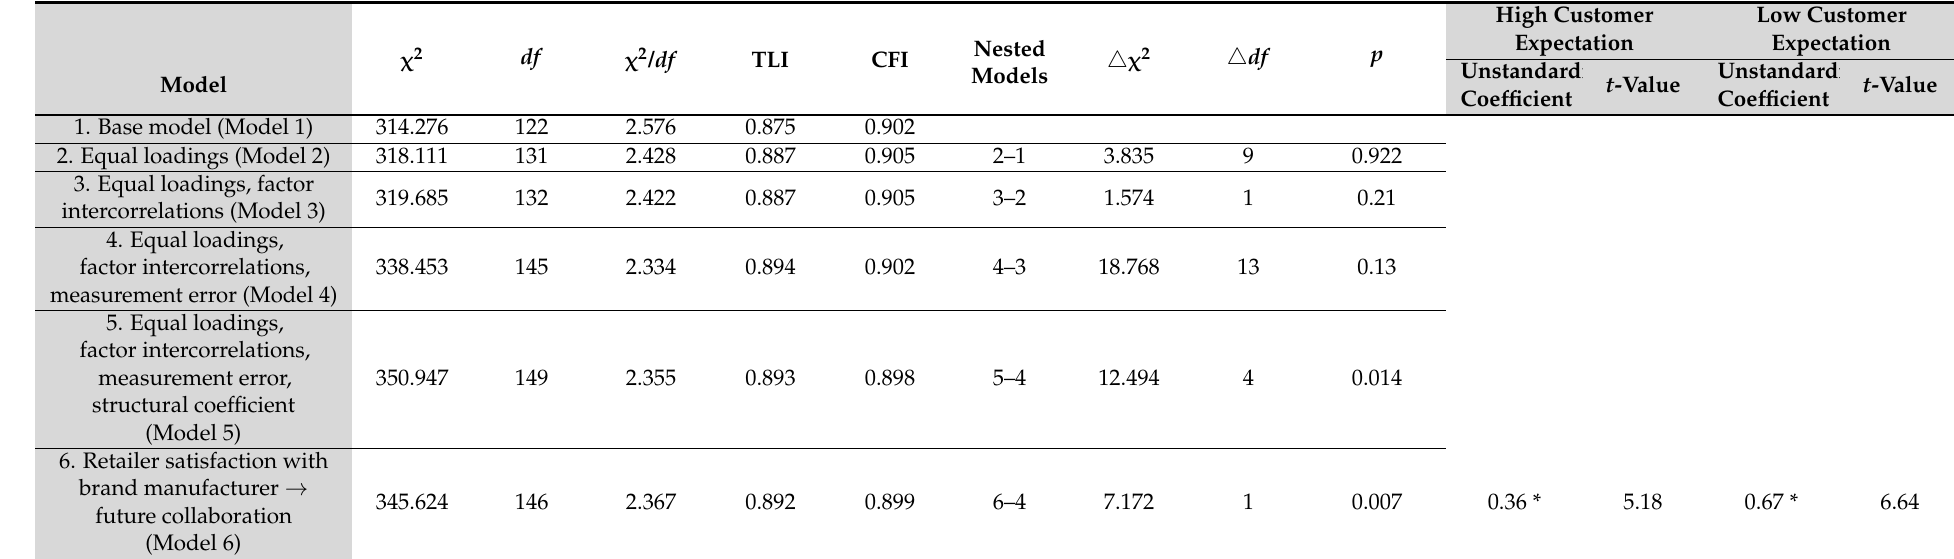
Table 10. Invariance Tests across Customer Expectation with